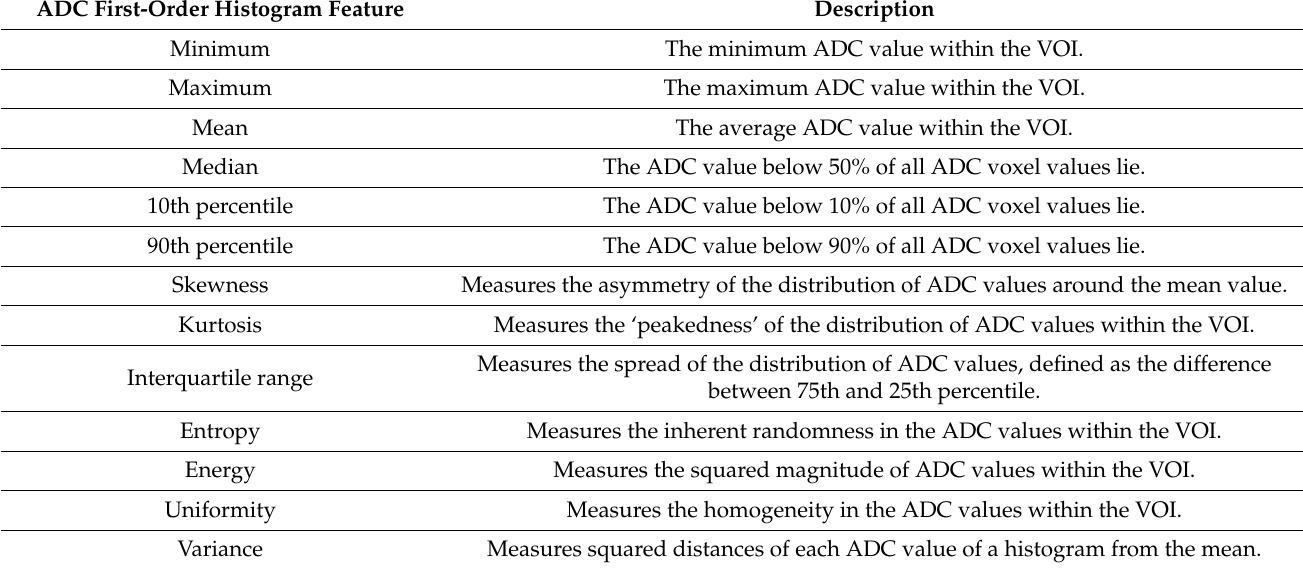
Table 2. Description of ADC first-order histogram-based